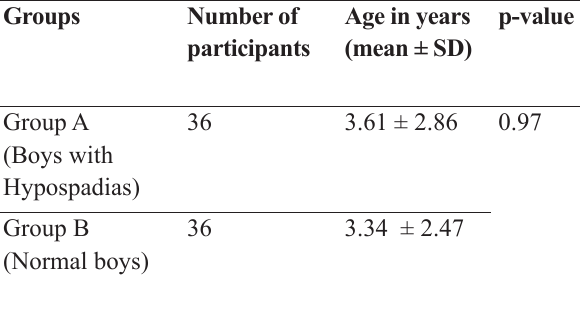
Table 1. Comparison of the mean age in both groups